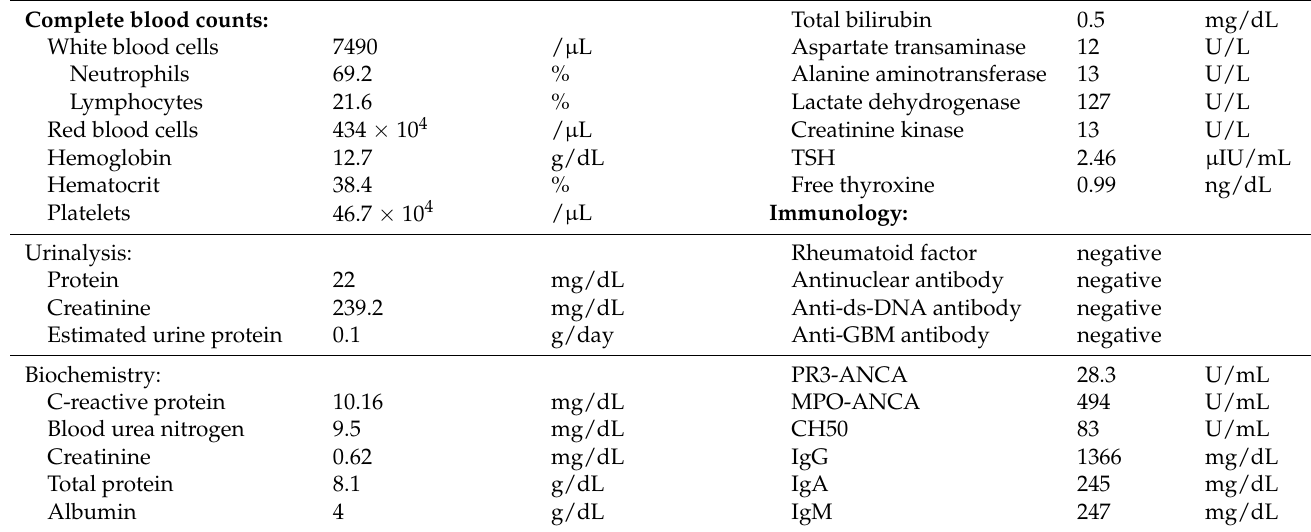
Table 1. The patient’s laboratory test results on